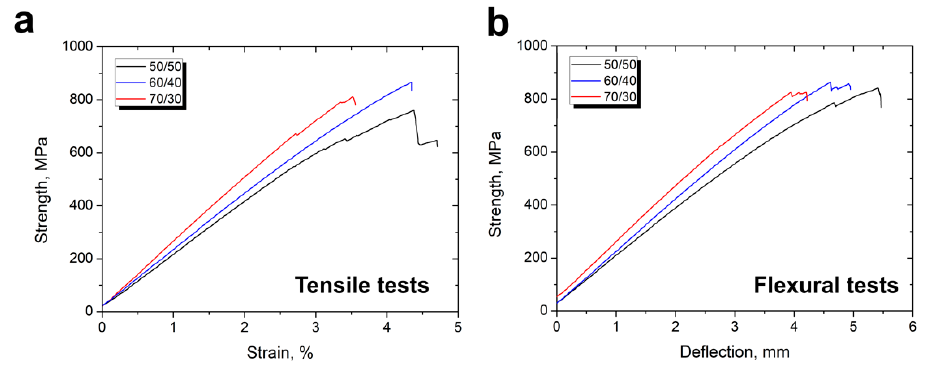
Figure 9. Typical stress–strain curves of the CF/PSU composites ( a ) during tensile and ( b ) flexural tests depending on the fiber content (initial fibers).